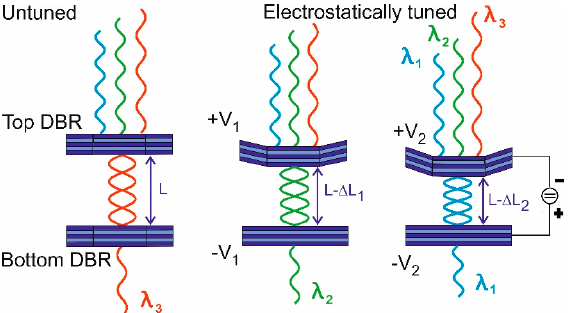
Figure 10. MEMS tunable FP filters with a single airgap. Examples for material systems are GaAs/AlAs, SiO 2 /Si 3 N 4 , or SiO 2 /TiO 2 . In this figure, a four-times half-wavelength (4· λ /2) cavity and electrostatic actuation is shown. The required partial metal layers are not drawn.